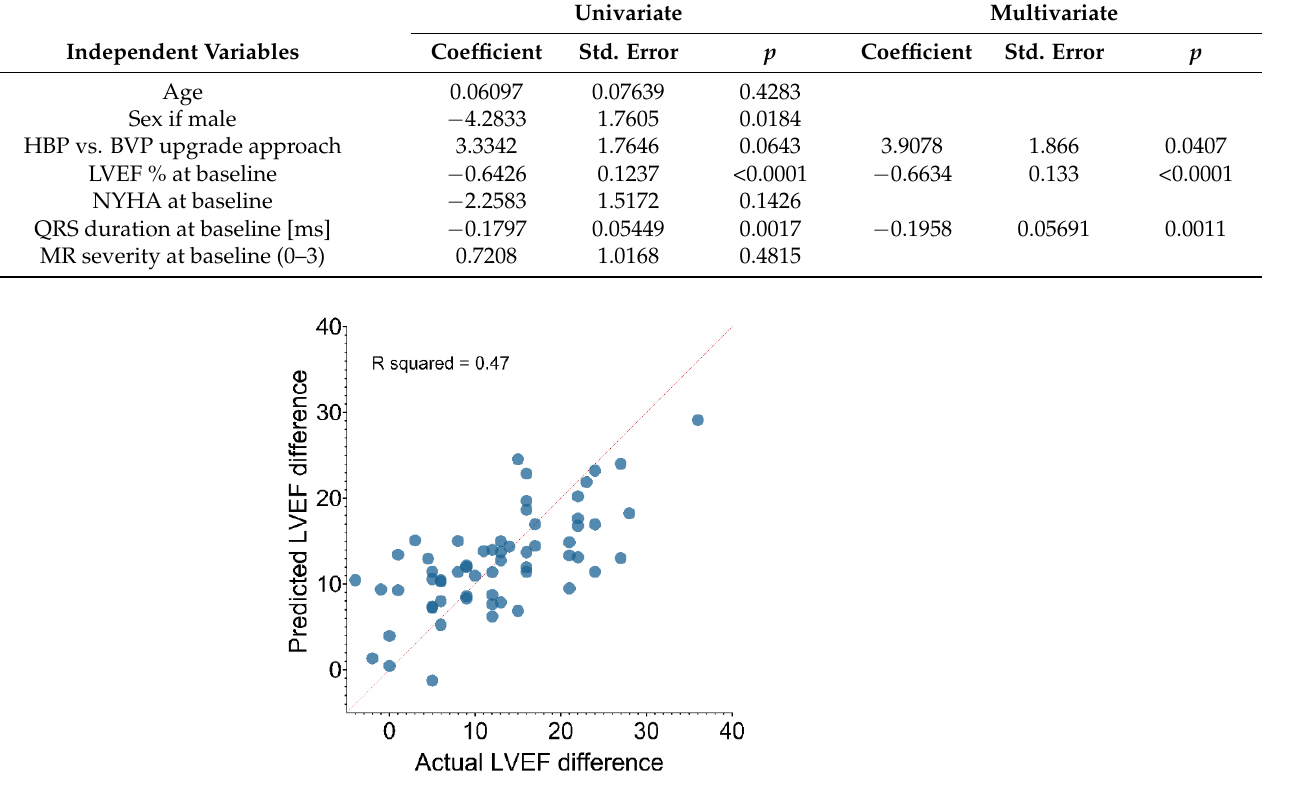
Figure 4. Predicted values against actual values for left ventricular ejection fraction difference before and after the upgrade procedure. LVEF—left ventricular ejection fraction.